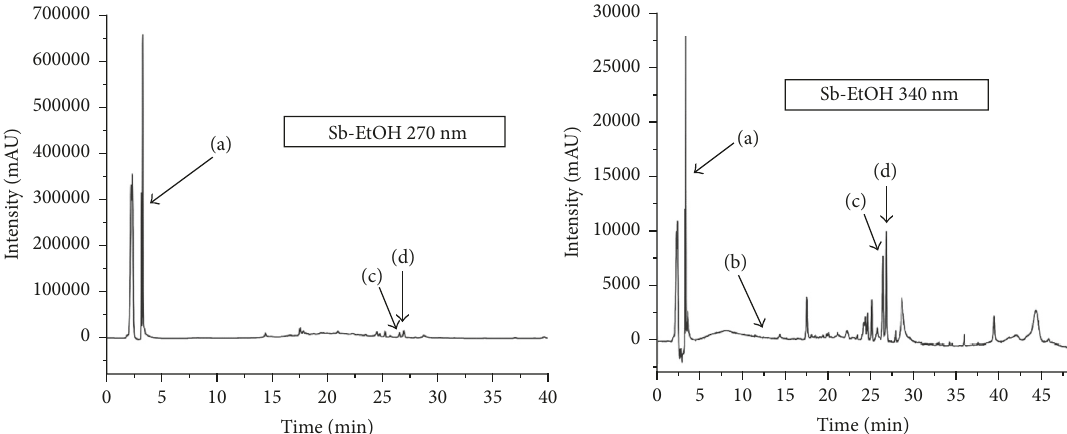
Figure 3: Identification of phenolic compounds in the crude ethanolic extract of the barks of Schinopsis brasiliensis using HPLC-DAD (270 and 340nm). (a) Catechin; (b) epicatechin; (c) apigenin; and (d) gallic acid.